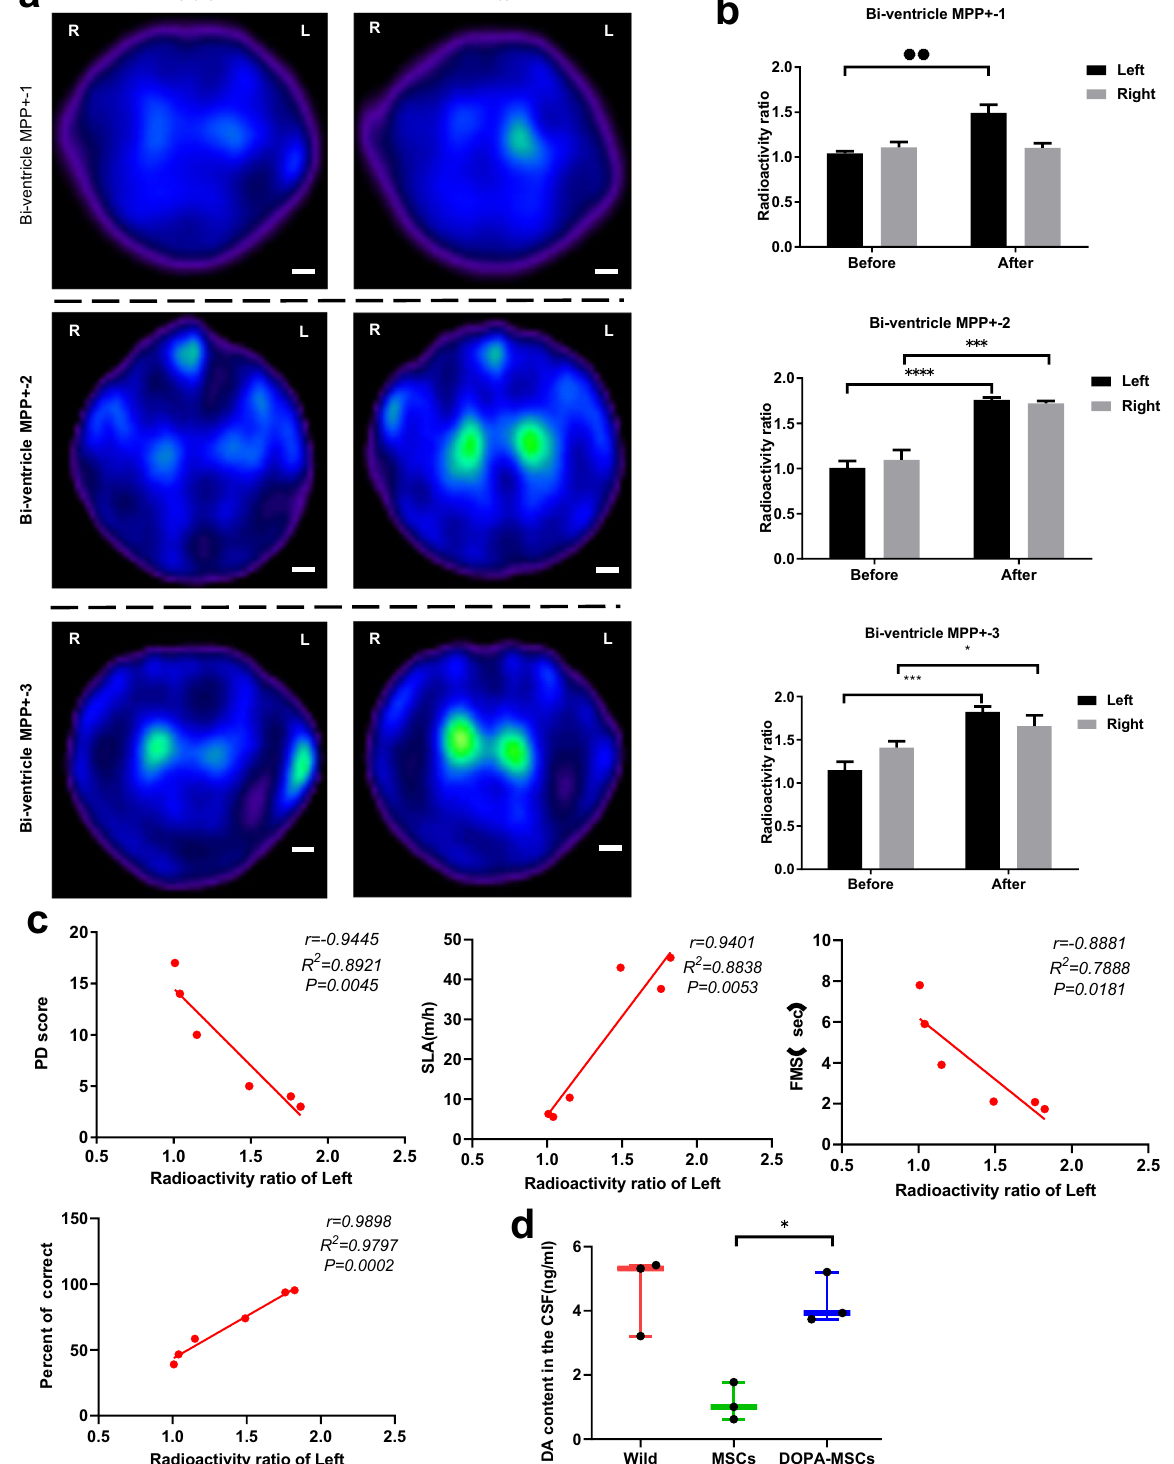
Fig. 5 DOPA-MSCs improved PD symptoms by secreting dopamine transmitters. a Radioactive uptake images of the position of the basal ganglia before and 6 months after DOPA-MSC transplantation in chronic PD monkeys ( n = 3). Scale bars, 1 cm. b Quanti fi cation of the radiation ratios of the left and right basal ganglia before and after DOPA-MSC transplantation in chronic PD monkeys. Data are presented as the mean ± s.d. ( n = 3). Signi fi cance was assessed by a two-tailed Student ’ s t -test. * p < 0.05; ** p < 0.01; *** p < 0.001. c Correlation between the ratio of radioactive uptake in the left basal ganglia and behavioral results in the Bi-ventricle MPP + group. Two-tailed Pearson ’ s correlation analysis was performed, and r and P values are shown. SLA spontaneous locomotor activity. d Detection of dopamine concentrations in cerebrospinal fl uid from different treatment monkeys. Data are presented as the mean ± s.d. ( n = 3). Signi fi cance was assessed by a two-tailed Student ’ s t -test, * p < 0.05; ** p < 0.01; *** p <